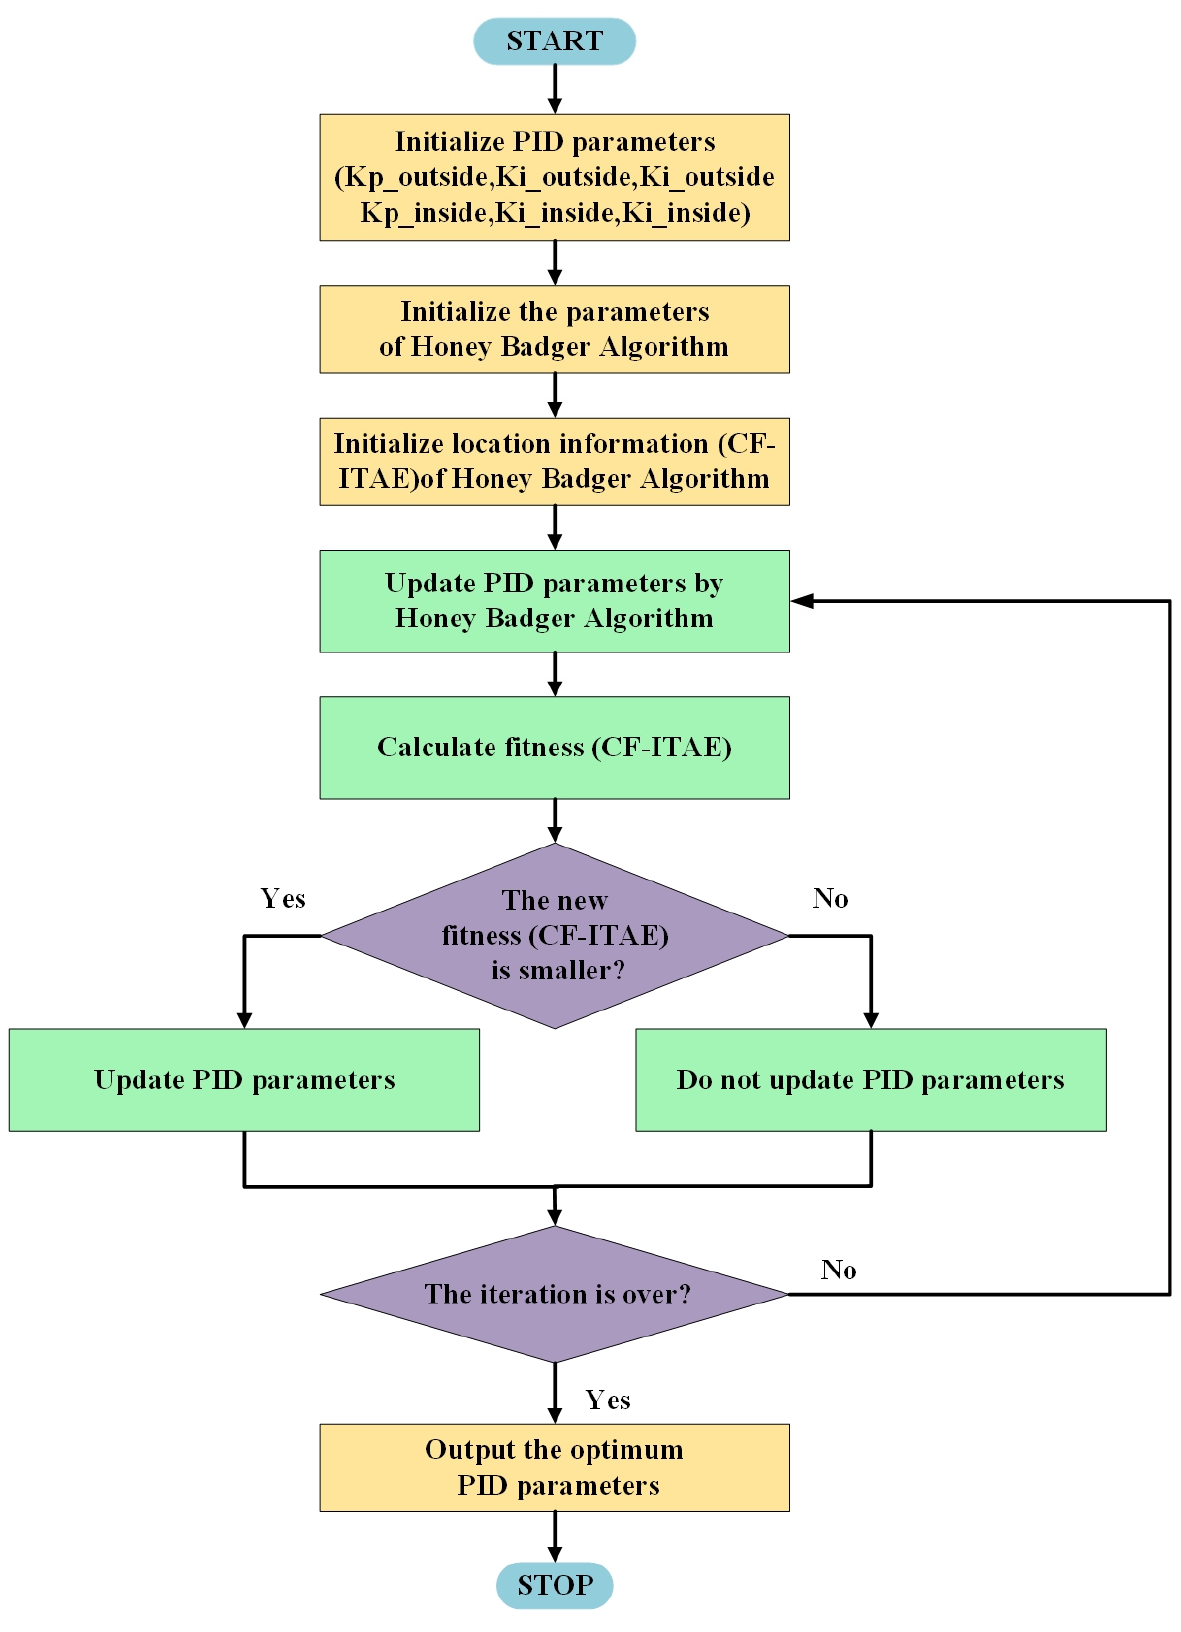
Figure 6. CFHBA-PID algorithm flow chart.